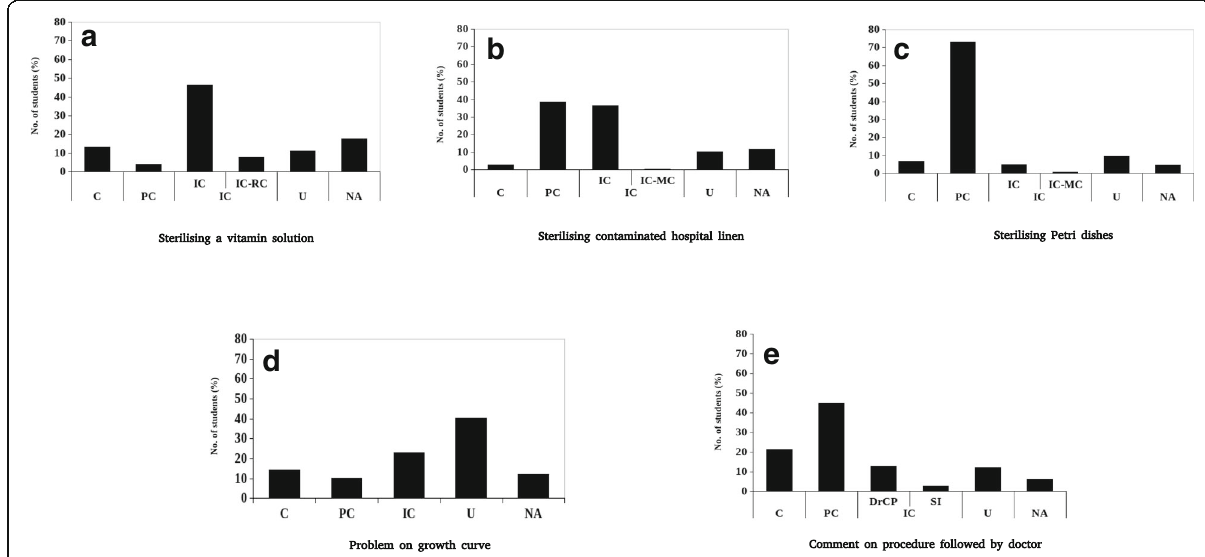
Fig. 1 Percentage of student responses in each category for the three questions identified by their keywords: a – c Subparts of the “ easy ” question, d “ moderate ” question, e “ difficult ” question. The x-axis represents categories of student responses. C Correct; PC Partially Correct; IC Incorrect; IC-RC Incorrect method, correct reason; IC-MC Incorrect reason, correct method; DrCP Doctor followed the correct procedure; SI Soap is an irritant; INC Incomplete; U Unrelated; NA Not